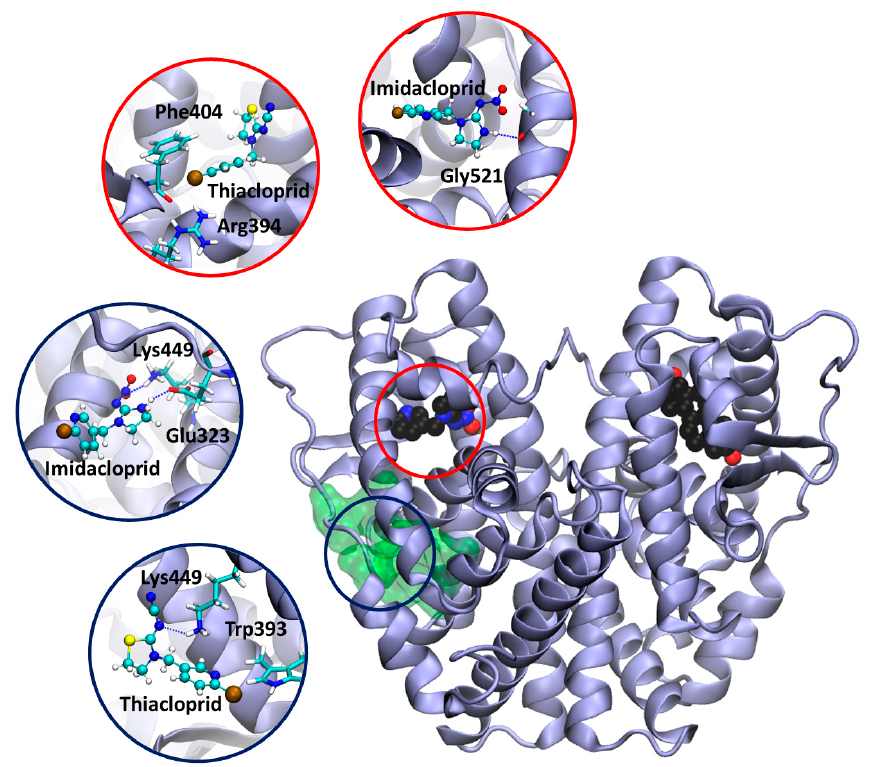
Figure 6. Model of estrogen receptor α dimer (PDB ID 1qku [52]) in complex with the neonicotinoids, imidacloprid and